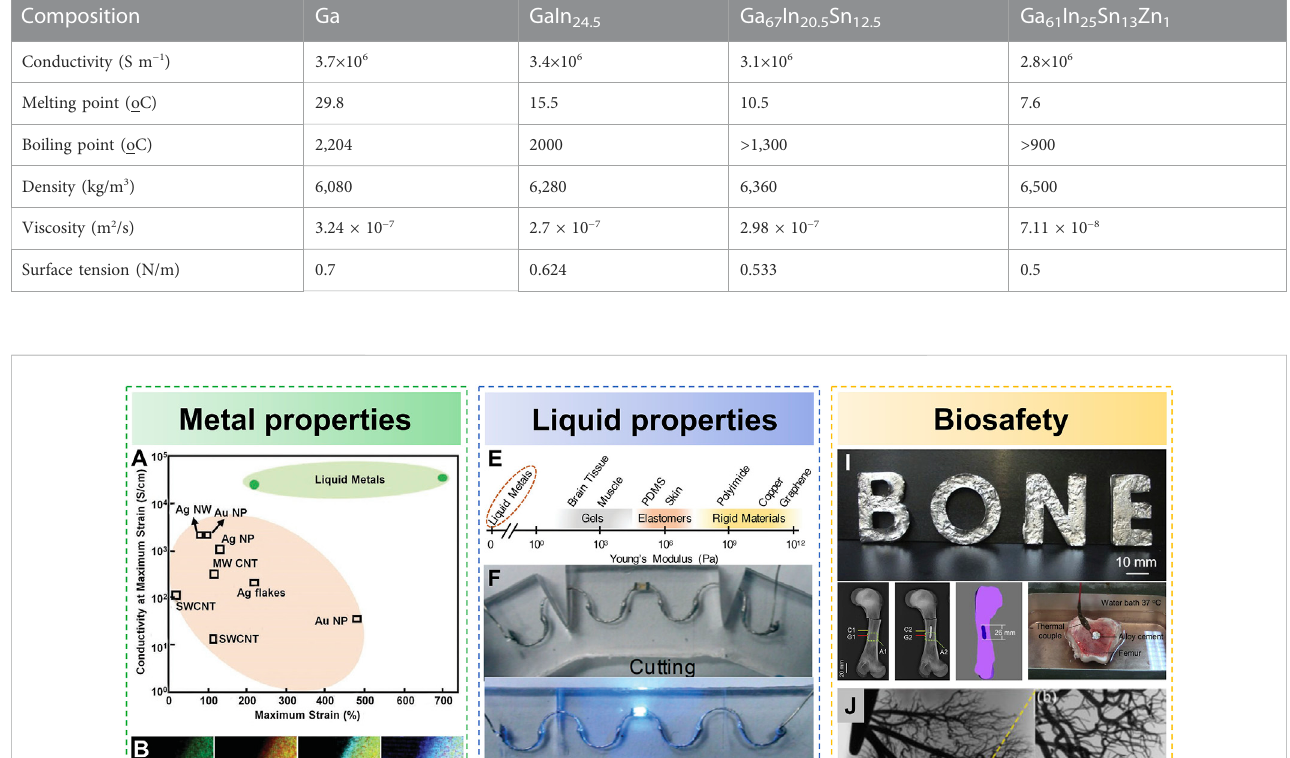
TABLE 1 The physical properties of gallium-based LM. Composition